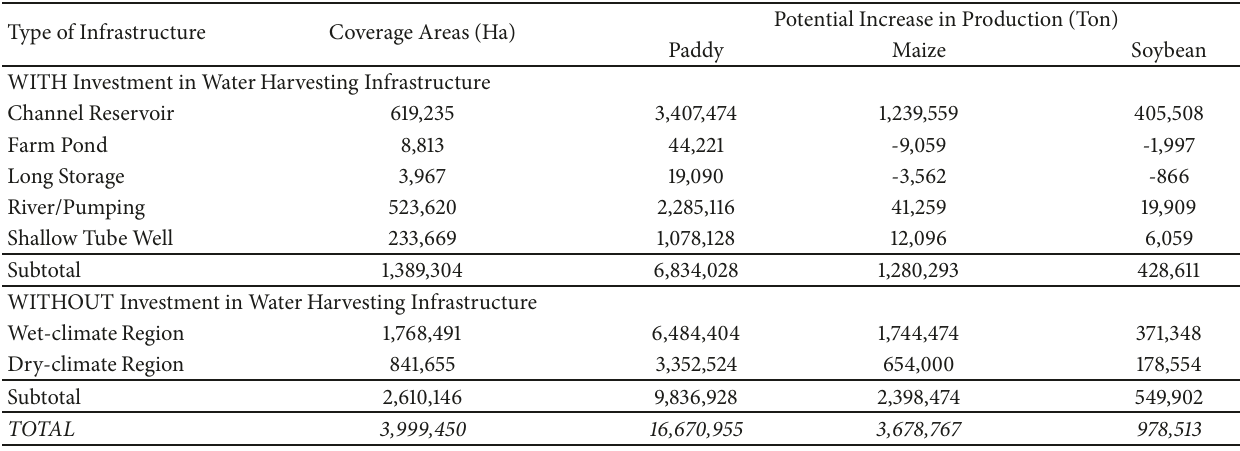
Table 5: Potential increase in crops production resulting from rain-fed fields WITH and WITHOUT investment in water harvesting infrastructure.